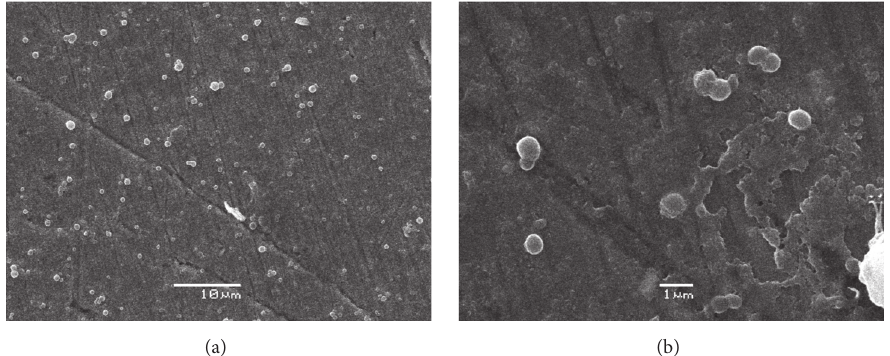
Figure 2: SEM microscopy of nanoparticles: (a) empty nanoparticles; (b) nanoparticles containing enoxaparin.